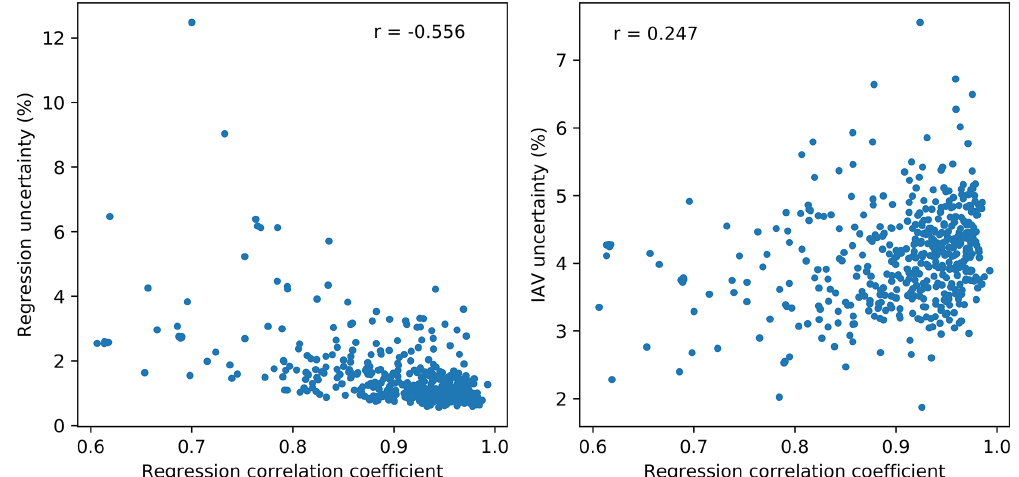
Figure 10. Dependence of linear regression uncertainty and IAV uncertainty on the R 2 of the regression between reanalysis wind speed and energy production